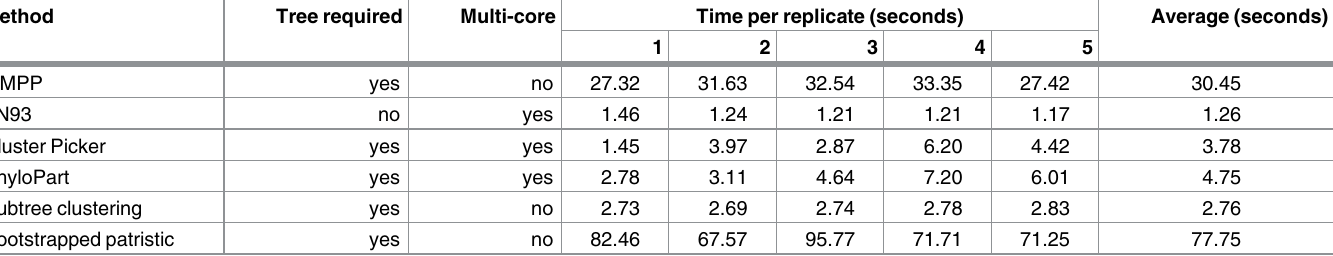
Table 1. Computing time required by six clustering methods to process five different trees each relating approximately 1000 simulated